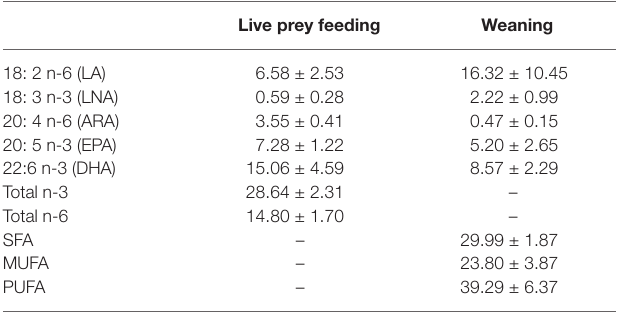
Data represent mean ± SD from all diet treatments at 9 and 17 DPH. LA, linoleic acid; LNA, linolenic acid; ARA, arachidonic acid; EPA, eicosapentaenoic